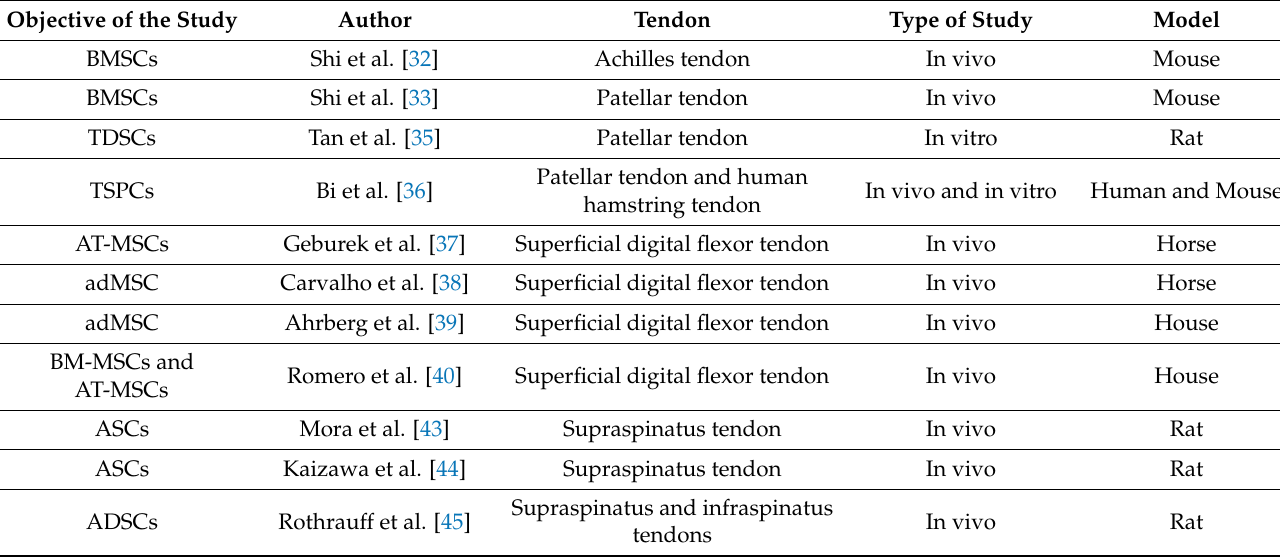
Table 1. A search of the literature, performed as described previously, allowed us to retrieve 11 studies on stem cells for tendon